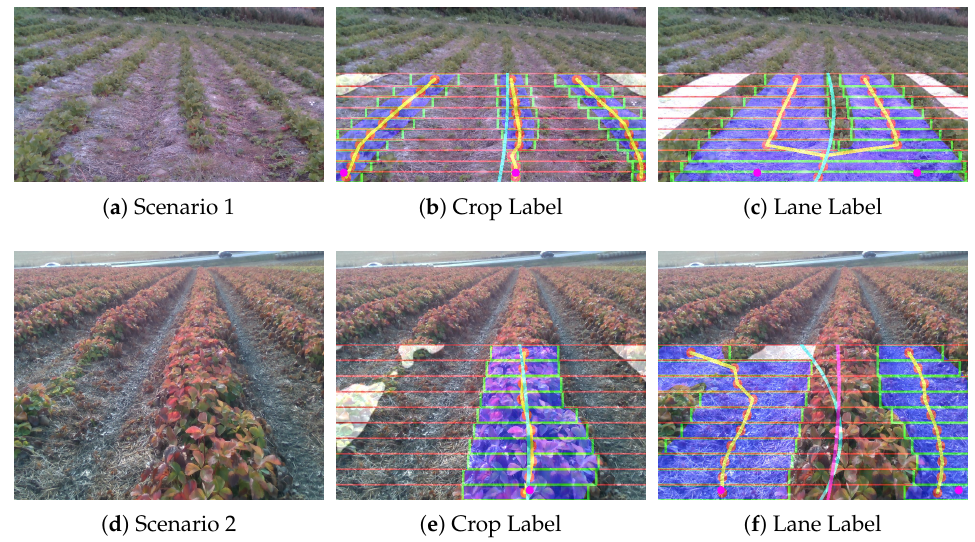
Figure 13. Handling of bare patches scenarios using adaptive multi-ROI